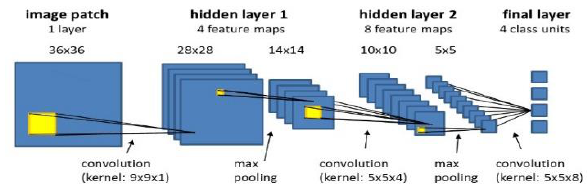
Figure 1. Overall architecture of Convolution Neural Network (CNN) (Trimble eCogntion software, 2019).